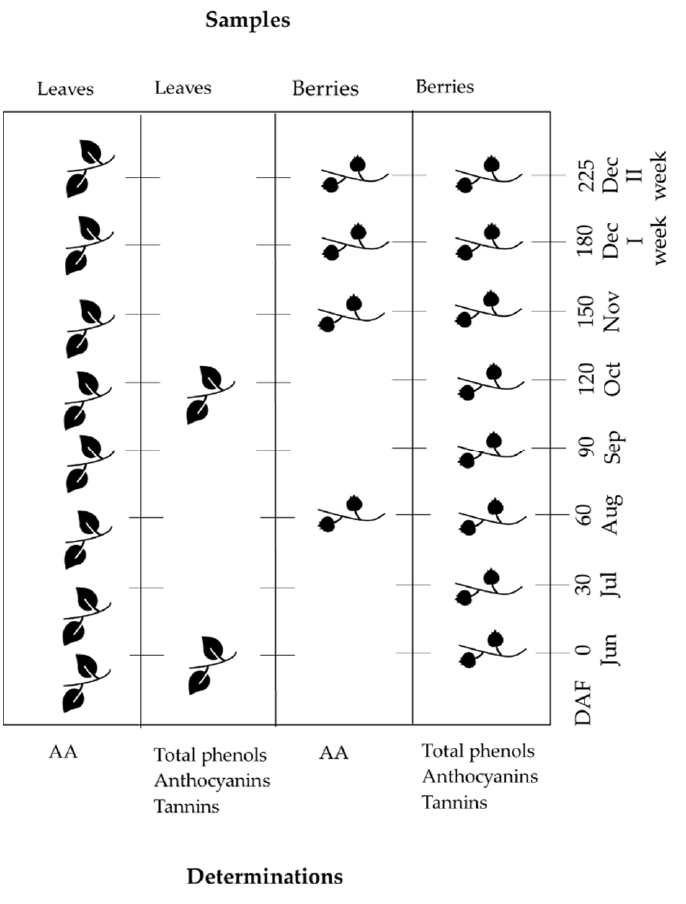
Figure 1. Graphical representation of the timing of sampling of myrtle berries and leaves. Acidified ethanol was used as extraction solvent. Ethanol is one of the most employed solvents for the extraction of phenolic compounds; moreover, a hydroalcoholic extract is the base for myrtle liqueur production [33–35]. Acidification allows avoiding oxidation and increases extraction of